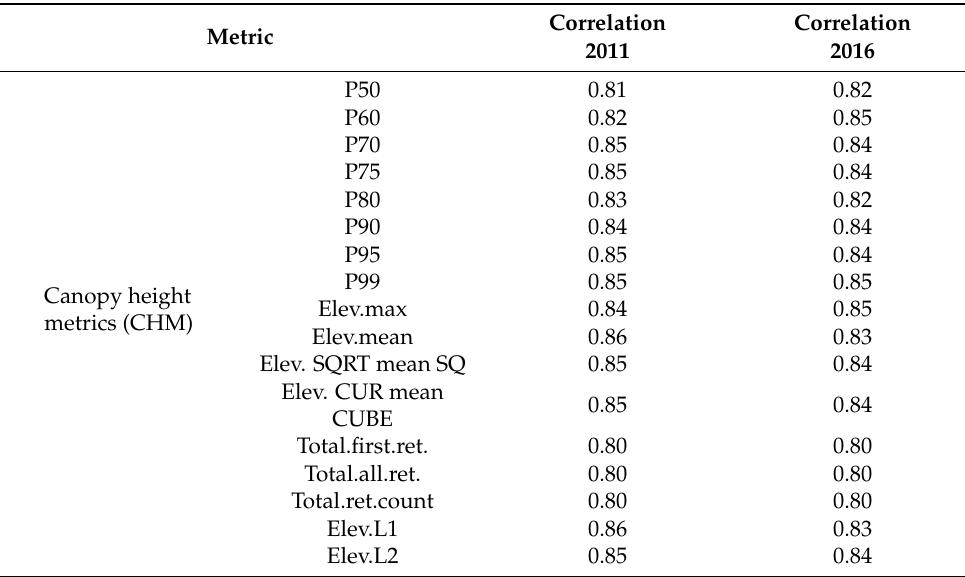
Table 6. Metrics with Spearman’s rank correlation coefficients used for fuel type classification. All the variables are significant at the 0.05